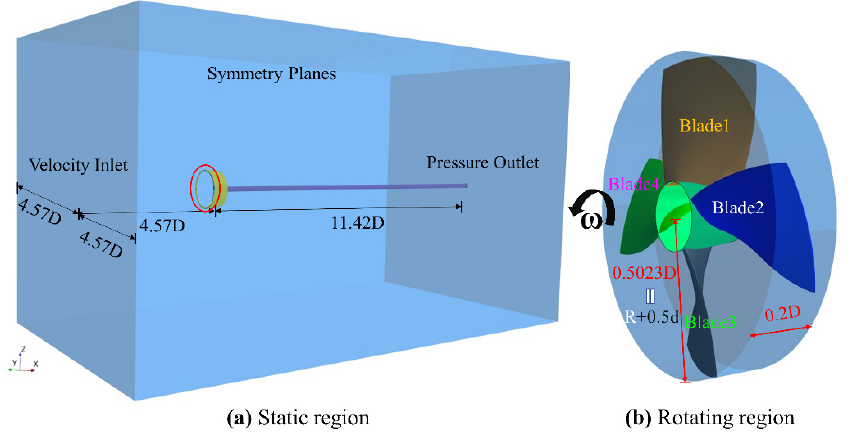
Figure 3. Specific values and boundary condition types of the ducted propeller.